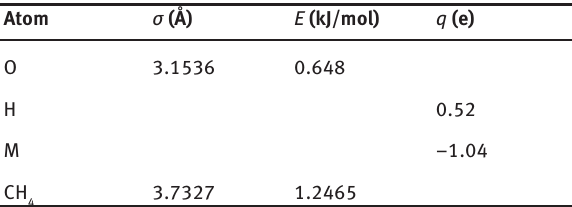
Figure 2 : Simulation model for 2×2×4 unit cells of sI methane Table 1: Force field parameters for methane and water.